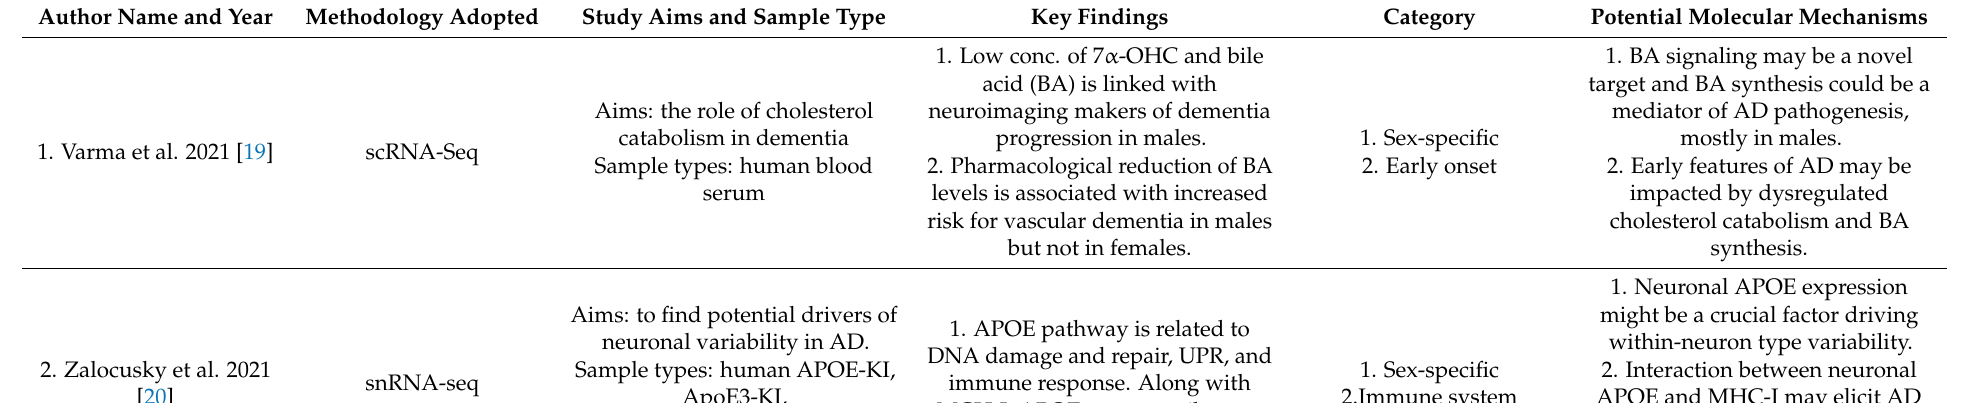
Table 1. Overview of the